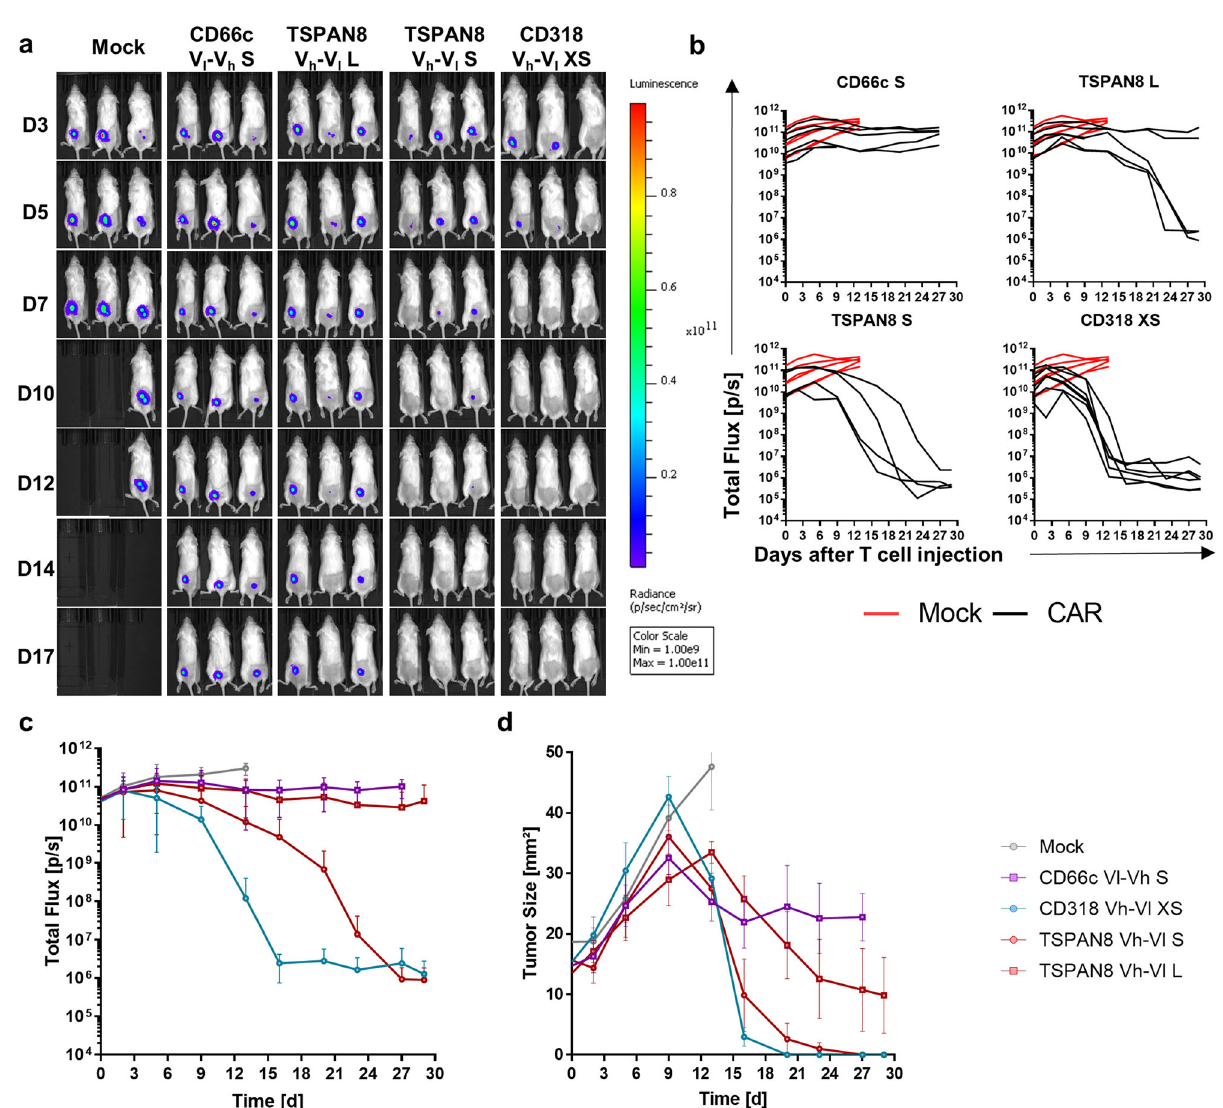
Fig. 4 Evaluation of CAR T cell in vivo functionality in an AsPC1 xenograft model. a Representative bioluminescence images of tumor-bearing NSG mice. Tumors were induced by subcutaneously transplanting luciferase expressing AsPC1 cells (color scale for all images, min = 1 × 10 9 , max = 1 × 10 11 ). Mice were randomized and treated upon established solid tumors reached 25 mm² (day 7) by intravenous infusion of 5 × 10 6 CAR T cells or Mock T cells. b Development of tumor burden for individual mice treated either with Mock T cells or with the respective CAR T cells (Mock: n = 6, CD66c S: n = 5, CD318 XS: n = 7, TSPAN8 S: n = 4, TSPAN8 L: n = 6). c Average bioluminescence signal ± s.e.m. of the respective treatment groups ( n equal to b ). d Average tumor size ± s.e.m. of the respective treatment groups ( n equal to b ). Source data are provided as a Source Data fi and TSPAN8 S had the highest CAR T cell counts at the end of L CAR exhibited heterogeneous response with three complete the experiment correlating with the highest anti-tumor activity responders and two mice showing stable tumor burden. The (Fig. 5a). In addition, the two low-responder mice showed the CD66c S spacer performed poorly in comparison but still stabi- lowest CAR T cell count inside the TSPAN8 L group. However, lized the tumor burden in all animals (Fig. 4b, c). Flow cytometric the comparable cell counts of the CD66c group showed that the analysis of spleen CAR T cells revealed that the groups CD318 XS CAR T cell number alone is not suf fi cient to explain the ef fi cacy.